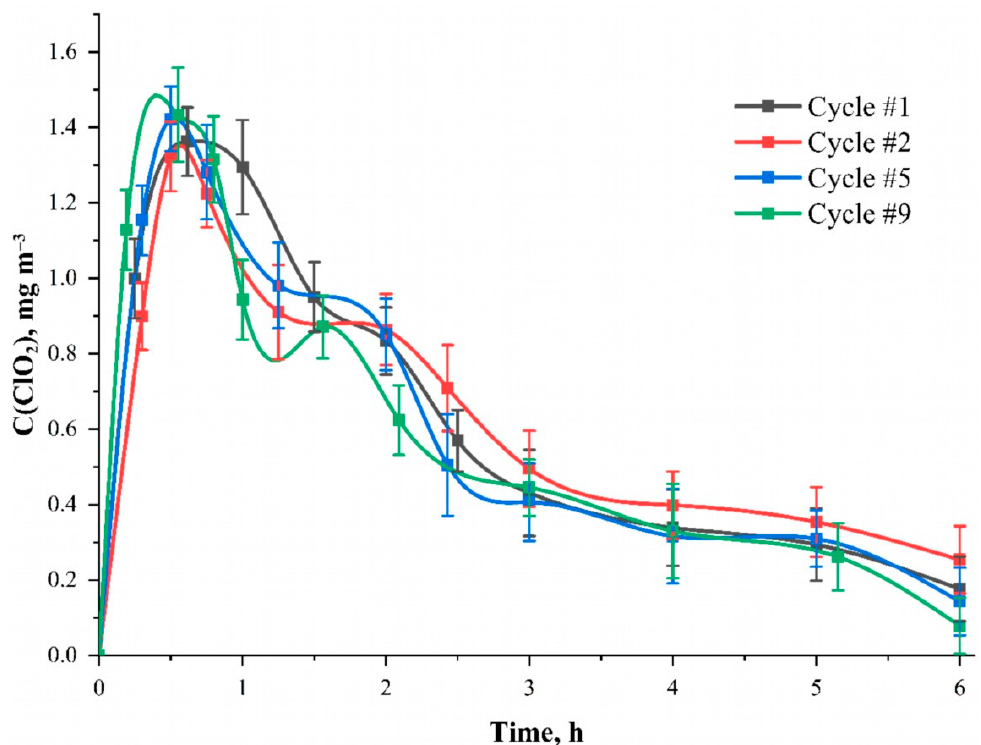
Figure 5. The dependence of the ClO 2 concentration inside the camera during repeated application (cycle) of the NaClO2 solution to the material surface at the time after the start of the reaction. Solution—C(NaClO 2 ) = 25.0 mmol L − 1 ; solvent—95 wt. % aqueous ethanol solution; carrier—cotton cellulose fabric with the content of phosphorus-containing groups equal to 0.802 ± 0.082 mmol g − 1